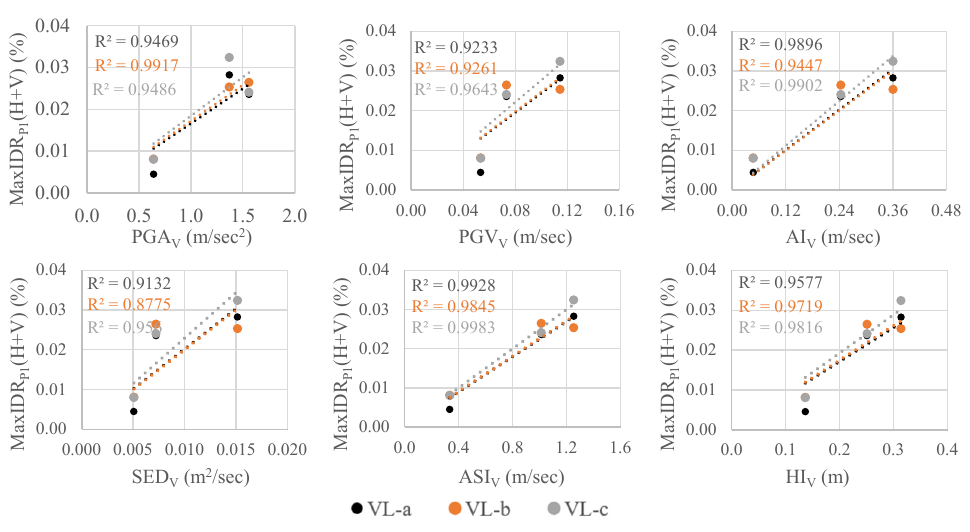
R² = 0.9908 R² = 0.9852